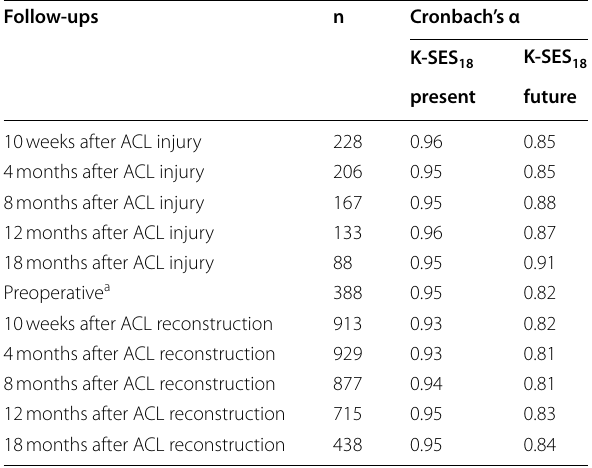
ACL injury refers to patients treated with rehabilitation, ACL reconstruction refers to patients treated with reconstruction and rehabilitation, K-SES 18 the 18-item version of the Knee Self-Efficacy Scale